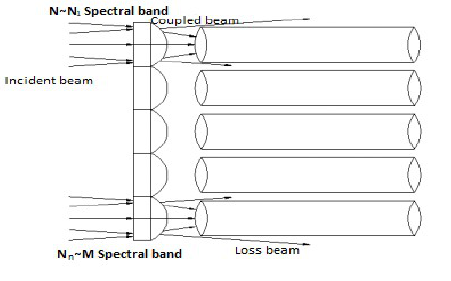
Figure 3 Microlens-fiber coupling system